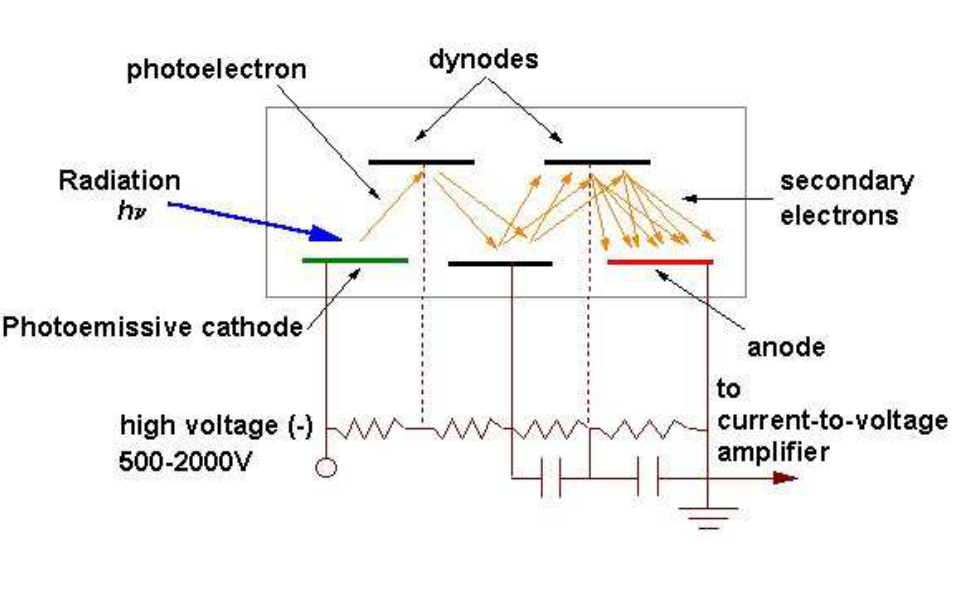
Figure 34. Schematic of a